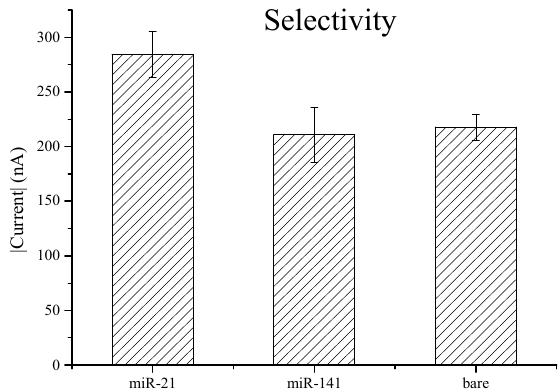
Figure 3. miR-21 nucleic-acid sensor selectivity comparison in 10 mM of miR-21, 10 mM of miR-141, and bare electrode using chronoamperometry.